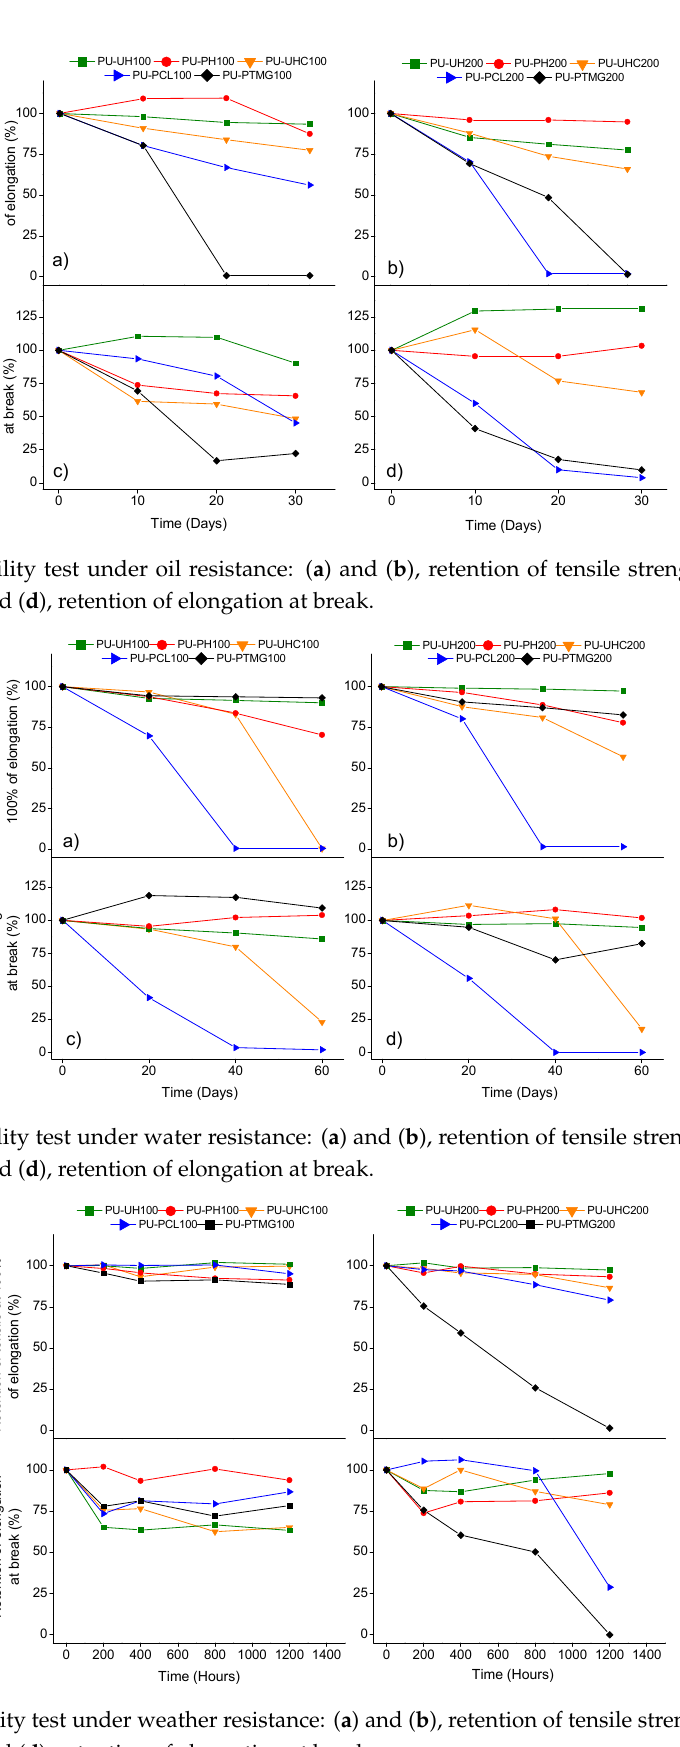
Figure 6. Durability test under heat resistance: ( a ) and ( b ), retention of tensile strength at 100% of elongation; ( c ) and ( d ), retention of elongation at break.